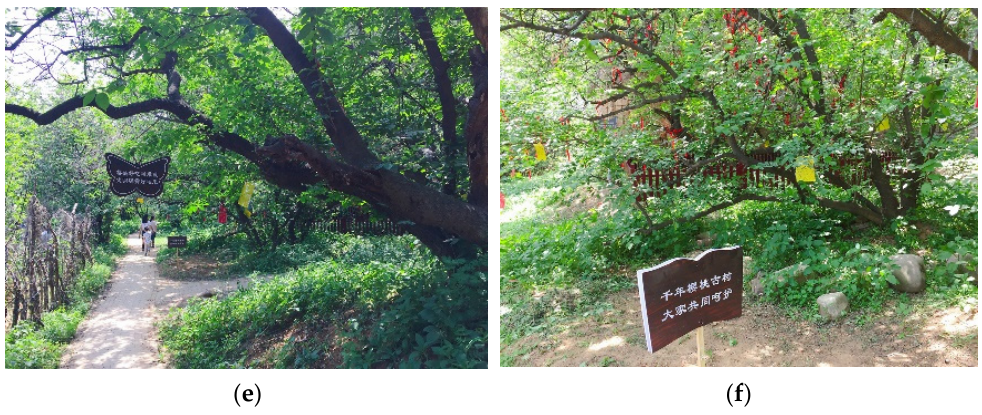
Figure 8. Example of TAL change in a corner of Matou Village. The change processes: ( a ) Inadequate management led to overgrowth of weeds; ( b ) Some ancient trees were replaced by seedlings of foreign varieties; ( c ) Some ancient trees and big trees were cut down or destroyed; ( d ) Some woodlands were converted to farmlands; ( e ) The ancient forest was relatively well preserved; ( f ) Key ancient trees were selected for salvage protection.